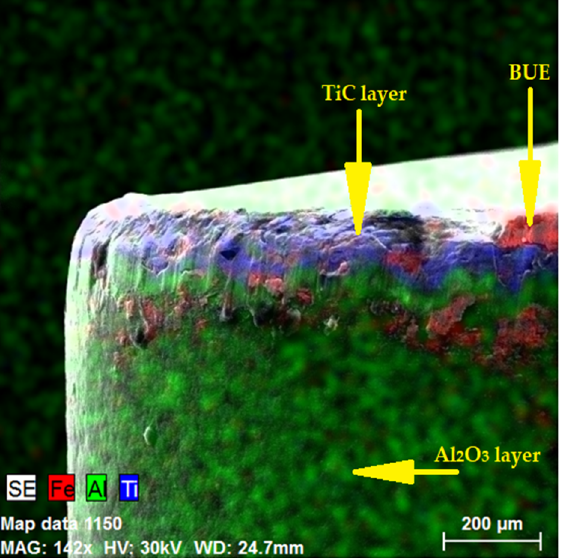
Figure 12. EDX analysis of wear range of CNMG 120408-MP3 WPP10S.